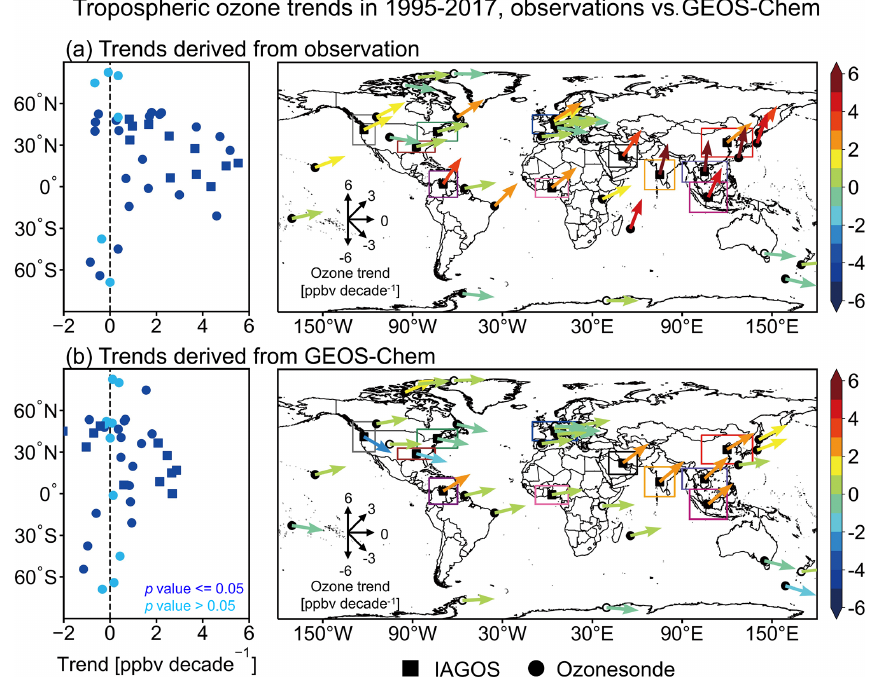
Figure 7. Comparison of tropospheric ozone trends of the 50th percentiles of the tropospheric column (950 to 250hPa) in 1995–2017 derived from (a) observation and (b) GEOS-Chem. Trends are estimated for 11 selected IAGOS regions and ozonesonde sites with frequent sampling. Symbol colors indicate the p value associated with the trend at each site and region in the left panel. Both directions and colors of the vectors in the right panel indicate the ozone change rates (ppbv per decade). Dark colors (left panel) and filled circles or squares (right panel) indicated trends with p < 0 .